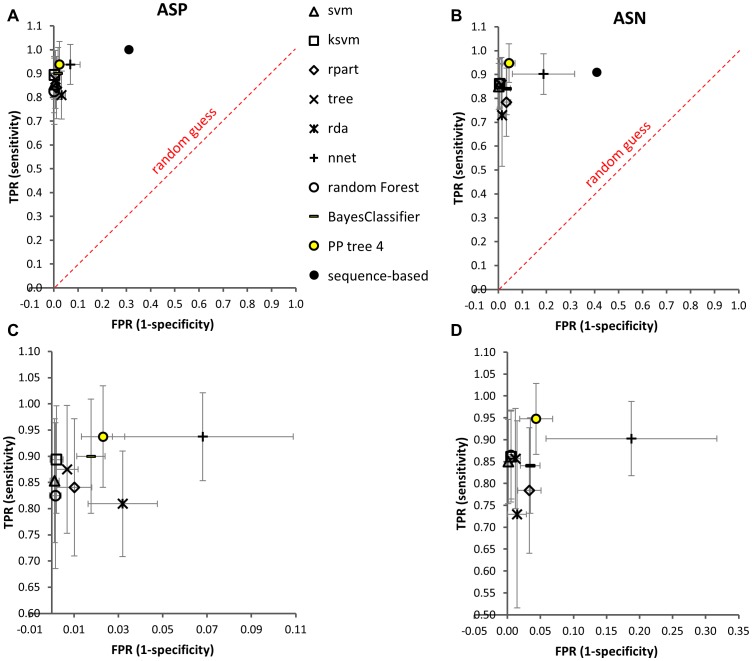
ROC plots for comparison of 3D classifiers to sequence-based prediction shows significant decrease of false-positive rates.Evaluation of different statistical methods is compared with only sequence-based prediction. For statistical classification methods, average numbers of false-positive and false-negative Asn/Asp residues are results of 40 rounds of Monte Carlo cross validation. TPR (true positive rate)  =  number of true positives divided by number of positives. FPR (false positive rate)  =  number of false positives divided by number of negatives. Tree, rpart, PP (Pipeline Pilot) tree, and RandomForest are recursive partitioning algorithms; svm, ksvm are support vector machine algorithms; rda is a regularized discriminant analysis algorithm; nnet is a neural network; sequence-based corresponds to prediction based on sequence motifs NG, NS, NT, and DG, DS, DT, DD, DH. The Pipeline Pilot tree, shown as a yellow circle, was selected as prediction algorithm, at pruning level 4. A: Asp model; B: Asn model. Panels C and D show a zoom view of the panels A and B, respectively. The numerical values shown in these graphs can be found in Table S3.